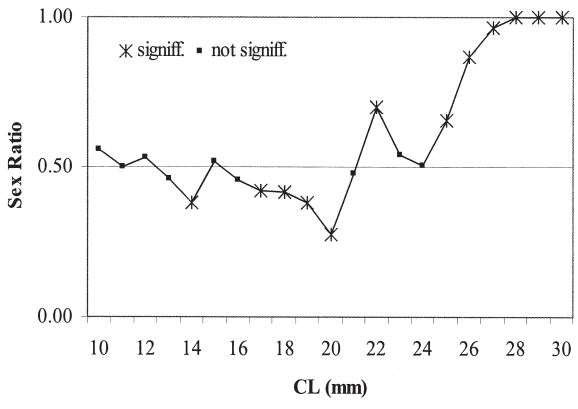
F IG . 4. – Representation of the sex ratios by size for Plesionika edwardsi , showing the significance of the dominance by sex in each size range (females dominance >